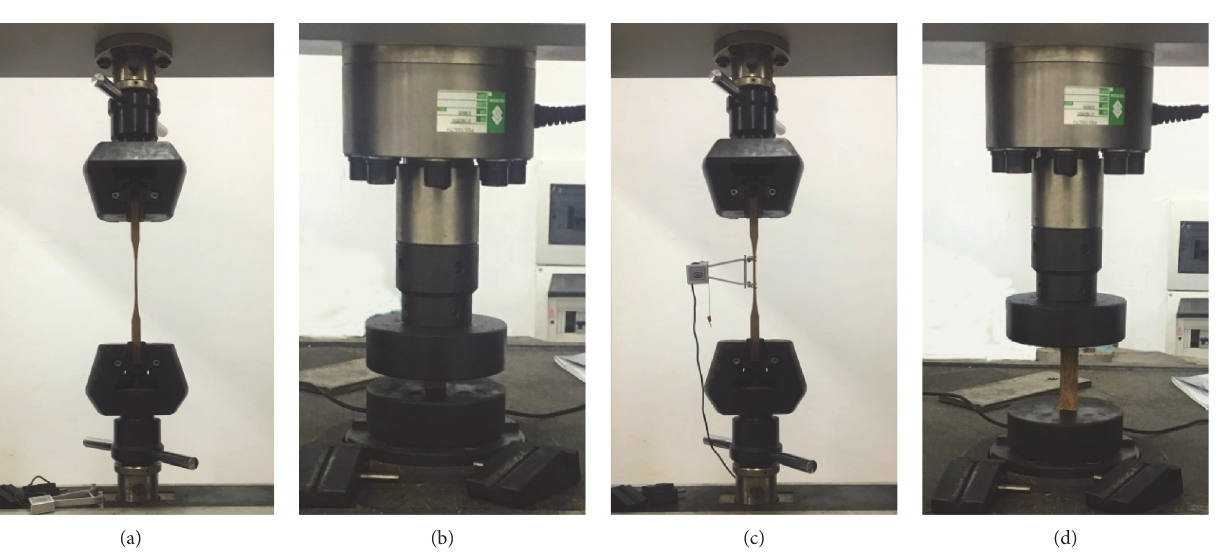
Figure 3: Material experiments of bamboo scrimber: (a) tensile strength, (b) compressive strength, (c) tensile elastic modulus, and (d) compressive elastic modulus.